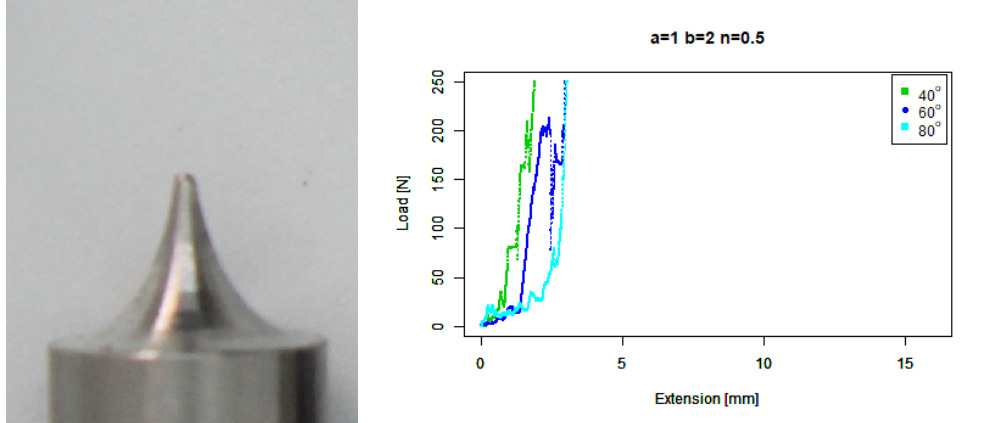
Figure 8. Extruded concave tip. ( Left ) Tip Profile. ( Right ) Experimental characterisation.